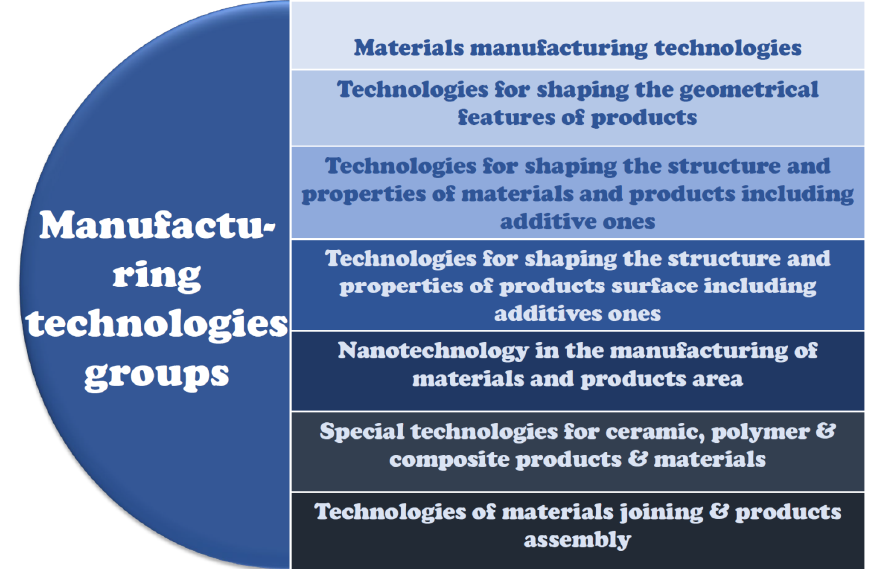
Figure 9. General classification scheme of product manufacturing technology.